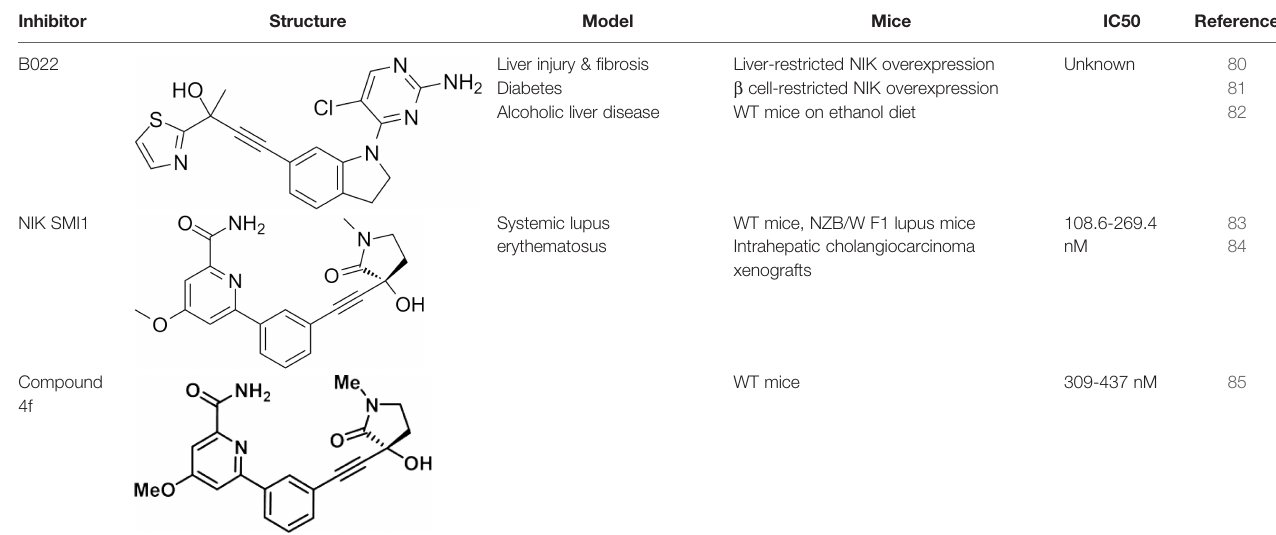
TABLE 2 | Overview of NIK inhibitors applied in vivo .